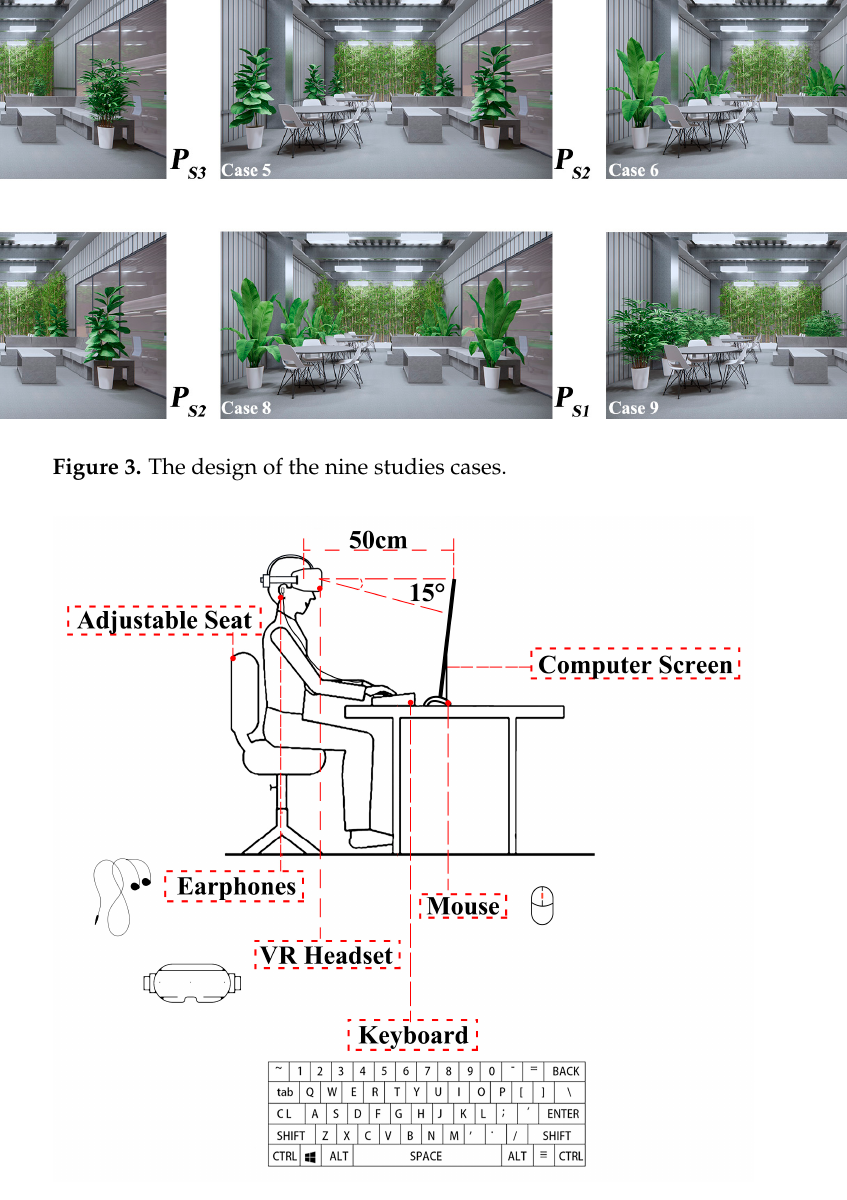
Figure 4. The visual recovery and attention task experiments site.